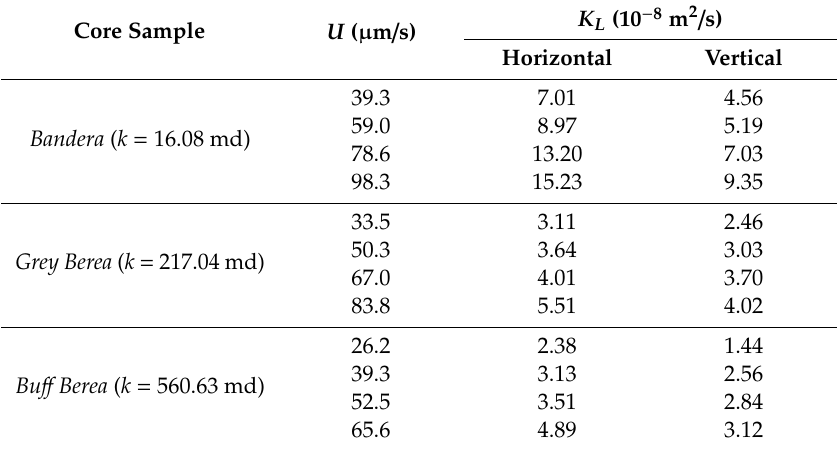
Table 5. Summary of all dispersion coefficients.